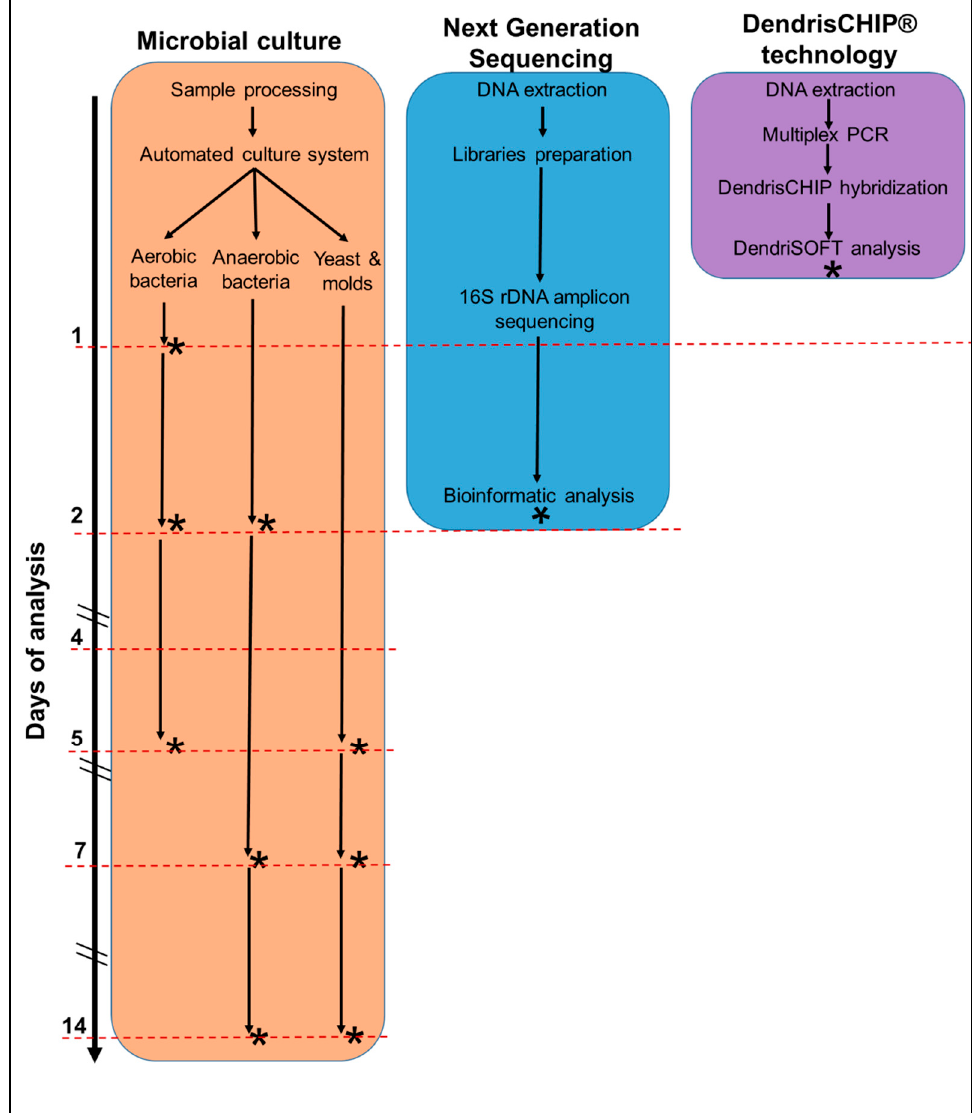
Figure 4. Time scale for the workflow of the microbial culture, NGS, and DendrisCHIP ® technology in PJI diagnostics. The asterisk indicate the time at which a diagnostic result can be provided.